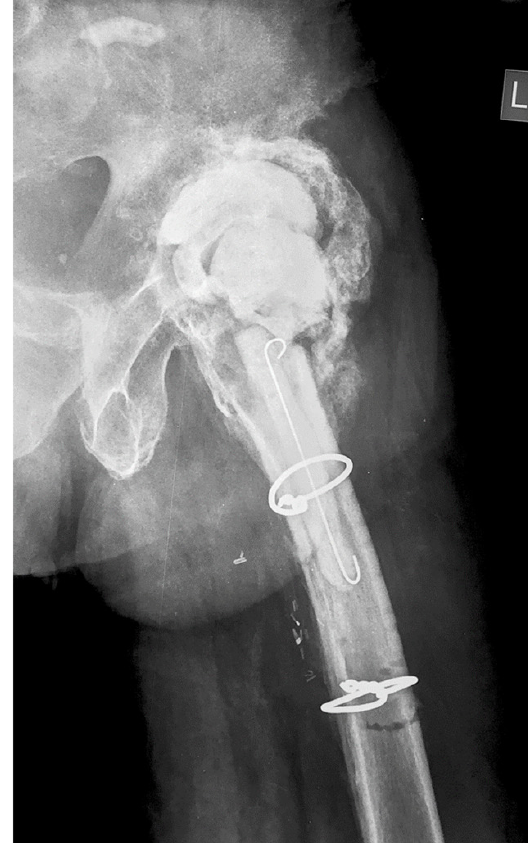
Figure 5: Anteroposterior radiograph of the left hip at the last follow-up shows a stable PMMA spacer, without any evidence of osteolysis or loosening, and with extensive periarticular heterotopic bone